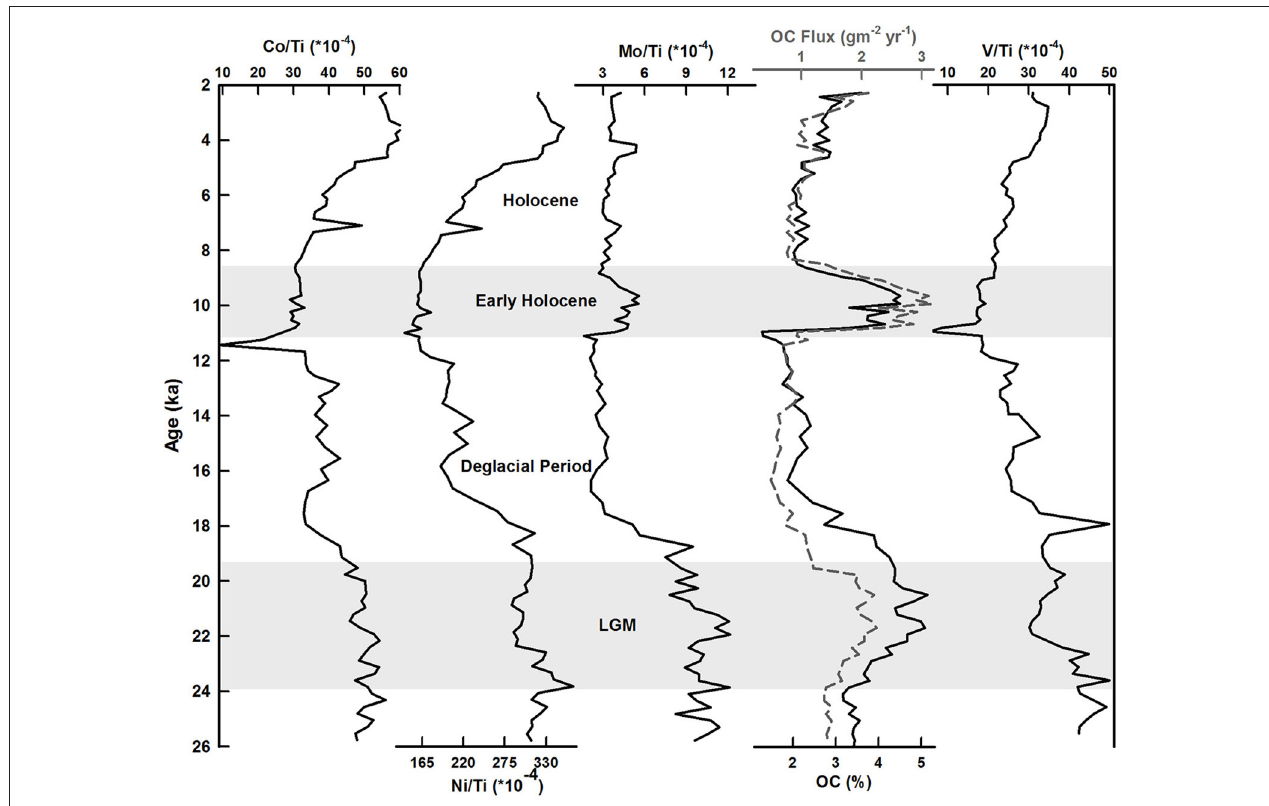
FIGURE 5 | Downcore variation of Ti normalized redox sensitive elements (Co, Ni, V, Mo), OC and OC flux. High values of OC and redox sensitive elements observed during